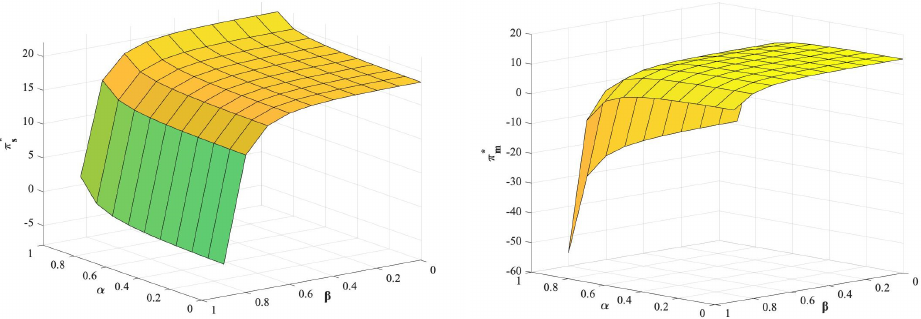
Figure 2. Profit changes of the supply chain members as two sharing coefficients varying.